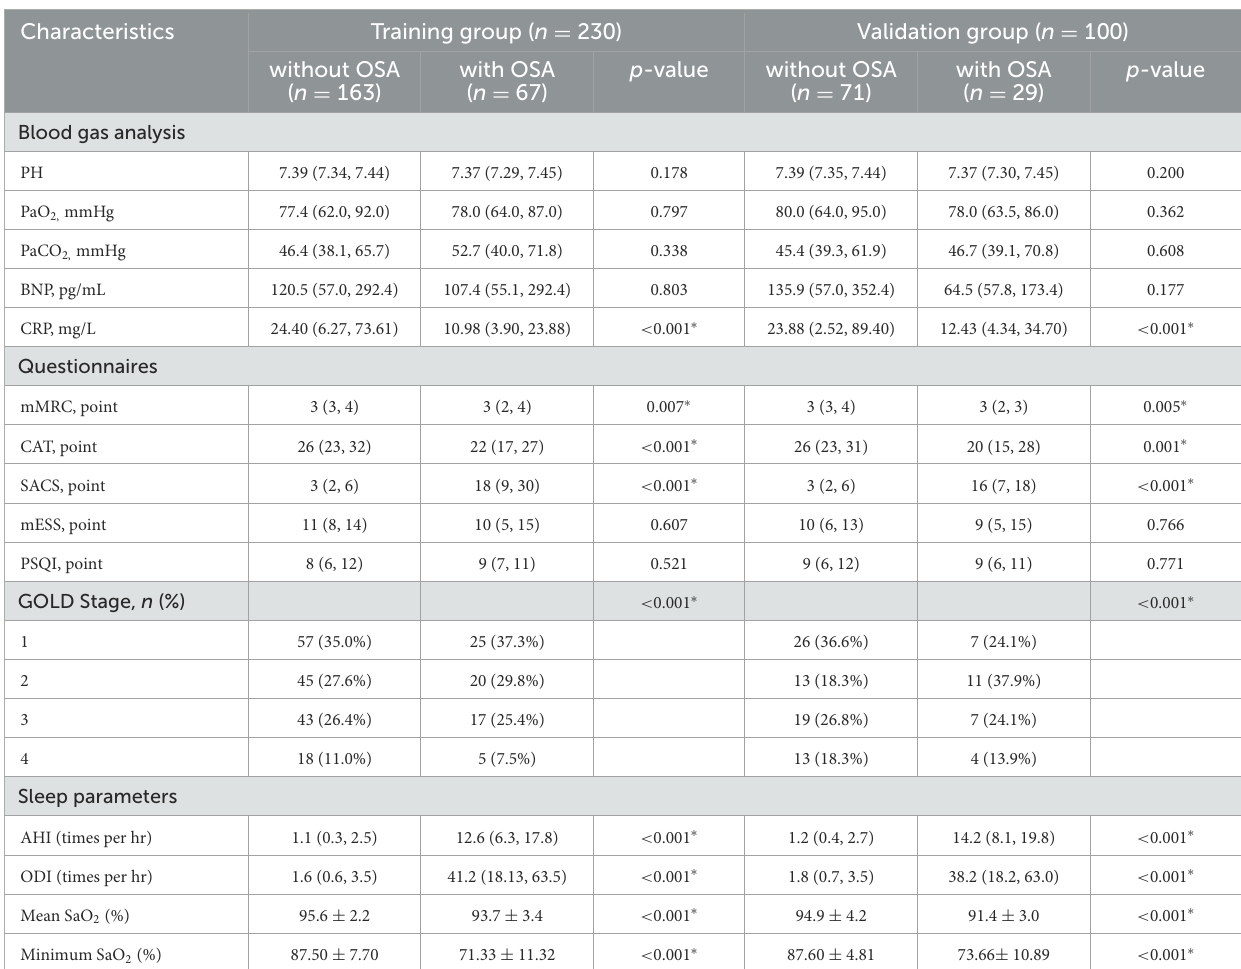
A total of 230 participants were randomly assigned to the training group and 100 to the validation group. Across the training and validation groups, 79.1 and 86.2% of patients with OSA, respectively, were men. In the training group, 67 (29.1%) patients were diagnosed with OSA, with a median age of 72 years. In